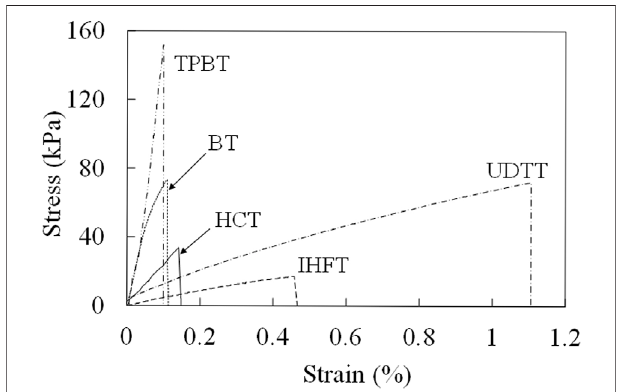
FIGURE 8 | Measured tensile strengths ( σ t ) and coef fi cients of variation ( C V )indifferenttestmethods. C V presentsratioofstandarddeviationtomean. Data sources for BT, HCT and UDTT are from Guan et al. (2022).